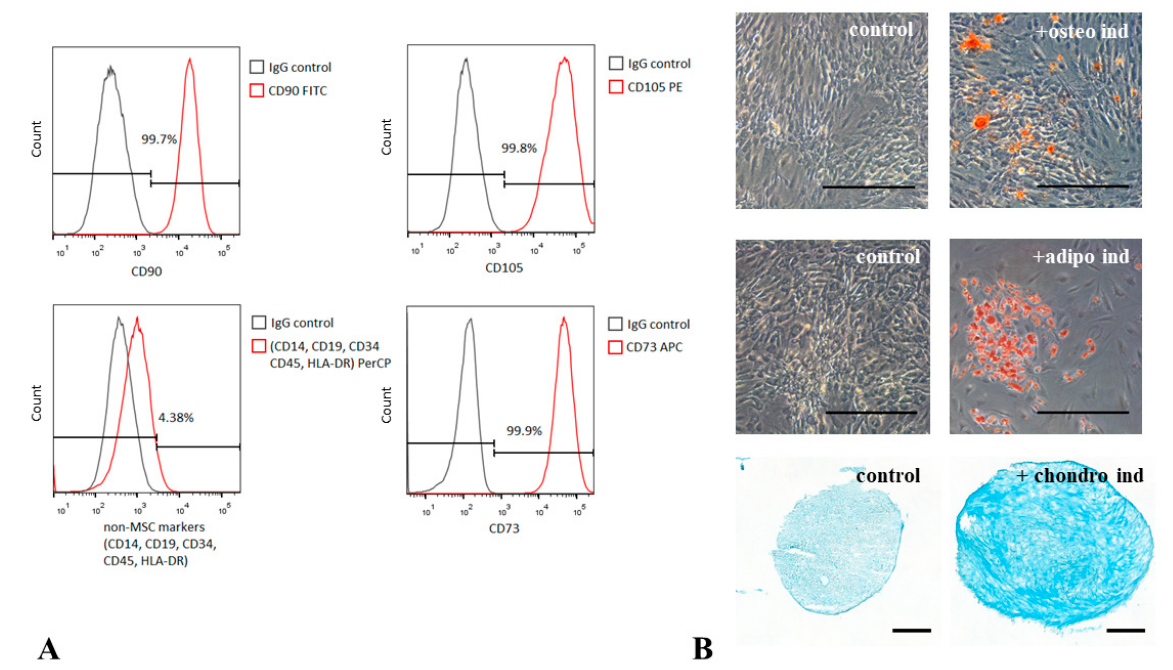
Figure 1. Human adipose-derived MSCs present characteristic features of multipotent mesenchymal stromal cells. ( A ) Evaluation of MSC markers by flow cytometry. More than 99% of MSCs express CD73, CD90, and CD105 on the cell surface. ( B ) MSCs differentiate into osteocytes (Alizarin Red S staining), adipocytes (Oil Red O staining) and chondrocytes (Toluidine Blue staining) under inductive conditions. Representative images, phase contrast microscopy, magnification ×100, scale bar 200 μ m.